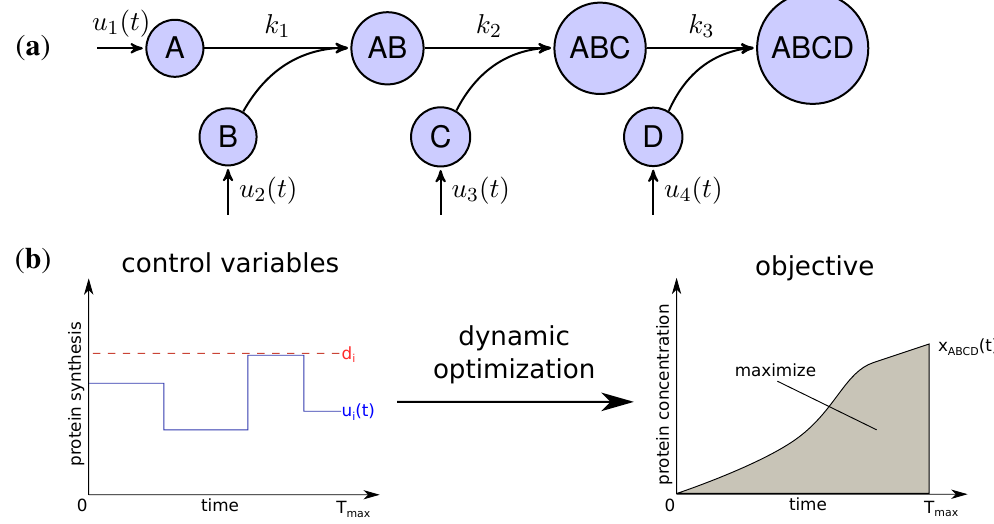
Figure 1. Scheme of the protein assembly model. ( a ) A,B,C and D are the subunits of the ( t ) are the control variables of heterotetramer ABCD. The corresponding synthesis rates u i the optimization problem and k the kinetic parameters of the assembly steps; ( b ) Dynamic l ( t ) under the constraints of maximum individual optimization determines synthesis rates u i synthesis rates d to maximize production of the complex i